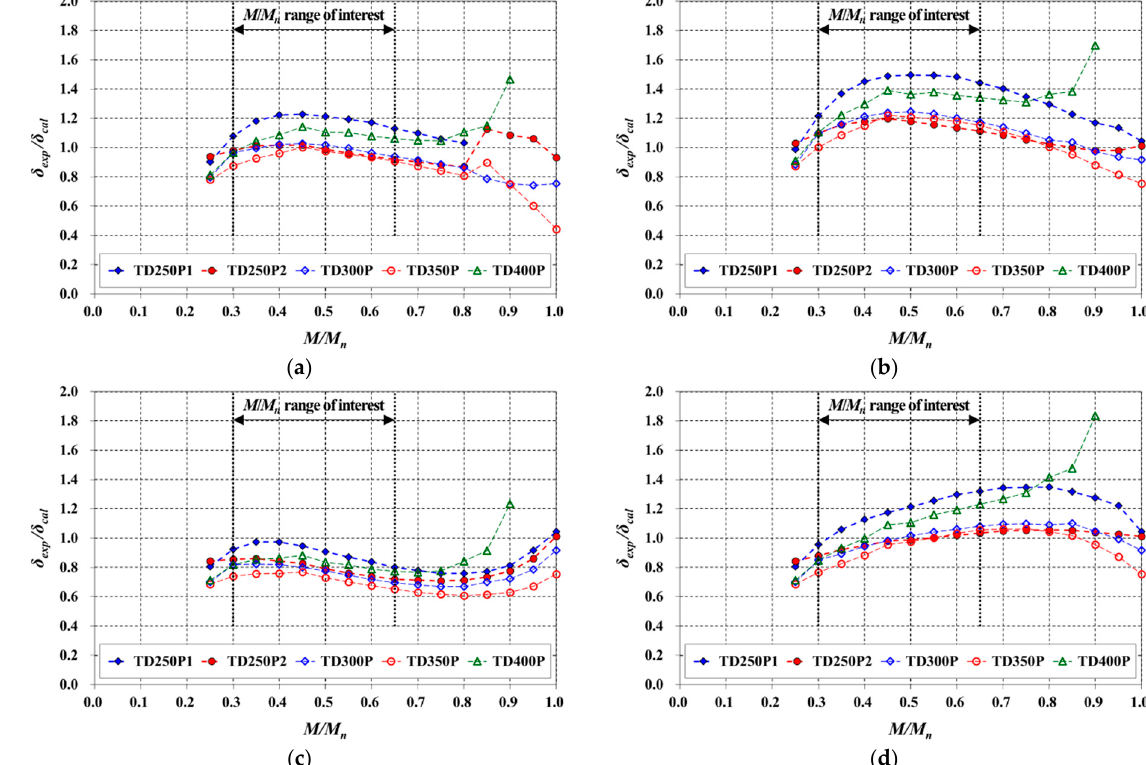
Figure 14. Comparison of immediate deflection predicted for the TD slabs using ( a ) Function 1 (linear); ( b ) Function 2 (convex); ( c ) Function 3 (concave); ( d ) Function 4 (cubic).